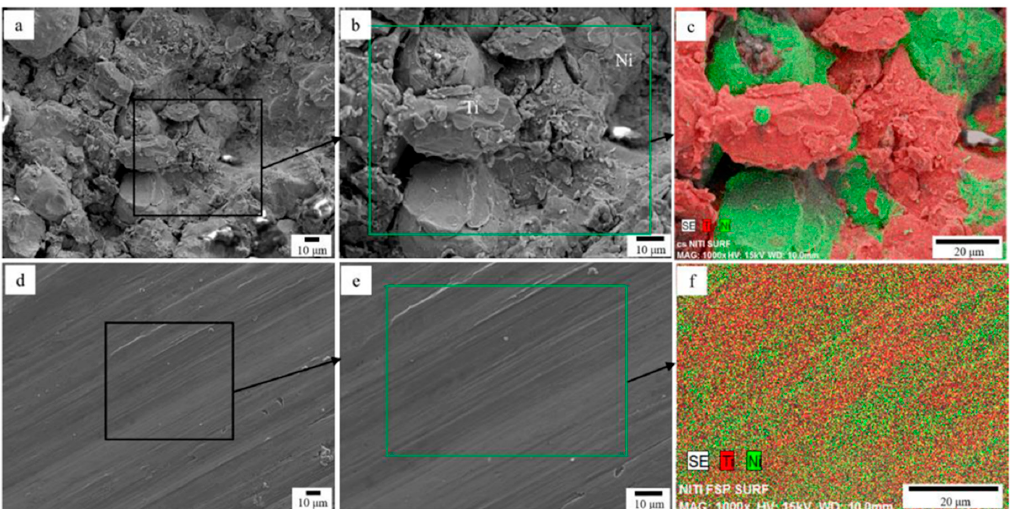
Figure 8. ( a , b , d , e ) SEM micrographs of surface morphologies of ( a , b ) as-sprayed and ( d , e ) FSPed Ni-Ti coatings, and ( c , f ) EDS mappings of Ni and Ti (adapted from reference [64] , with permission from © Elsevier).